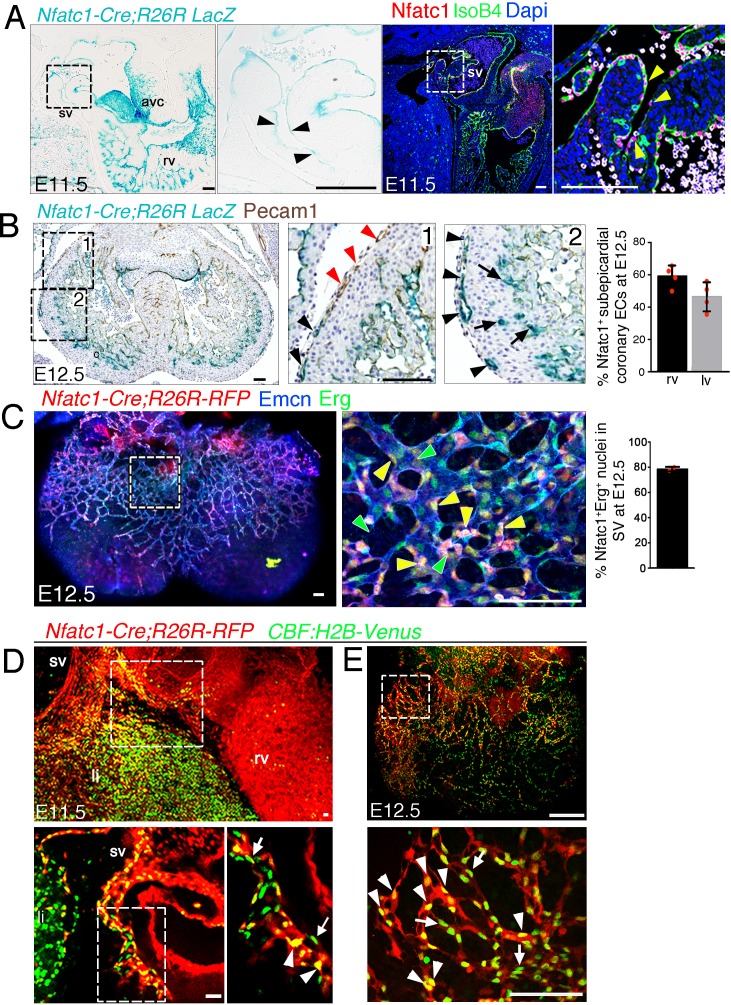
Most ventricular free-wall coronary vessels derive from Nfatc1+ progenitors.Nfatc1+ progenitors give rise to most coronary vessels. (A) Left: Sagittal section of a E11.5 Nfatc1-Cre;R26R-LacZ heart, showing LacZ expression in the sinus venosus (sv; arrowheads in inset), right ventricle (rv), and atrioventricular canal (avc). Right: Sagittal section of a E11.5 control heart immunostained for Nfatc1 (red) and IsoB4 (green); yellow arrowheads indicate nuclear Nfatc1 staining in SV endothelial cells. Dapi counterstain (blue). Scale bars 100 μm. (B) E12.5 Nfatc1-Cre;R26R-LacZ heart co-stained for LacZ and Pecam-1. (1) LacZ staining is weak in vessels proximal to the AVC (red arrowheads) and strong in distal vessels (1, 2, black arrowheads). (2) LacZ staining in vessels close to chamber endocardium is consistent with an endocardial origin of coronary arteries (arrows). The chart shows Nfatc1-positive vessels (Nfatc1-Cre-driven LacZ expression) as a percentage of all sub-epicardial vessels (Pecam-1-stained). Data are mean ± s.d. (n = 3 sections from four embryos). (C) Whole-mount E12.5 Nfatc1-Cre;Rosa26-RFP heart (dorsal view), showing RFP fluorescence (red) and immunhistochemistry for Emcn (blue) and Erg (green). Sub-epicardial vessel endothelium contains Nfatc1-Cre;Rosa26-RFP-positive nuclei (yellow arrowheads) and Nfatc1-Cre;Rosa26-RFP-negative nuclei (green arrowheads). Dapi counterstain (blue). The chart shows Nfatc1-Erg dual-positive nuclei as a percentage of all nuclei in subepicardial vessels. Data are mean ± s.d. (n = 2 hearts). Scale bars, 100 μm. (D) Whole-mount E11.5 Nfatc1-Cre;Rosa26-RFP:CBF:H2B-Venus heart (dorsal view), showing RFP reporter fluorescence (red) and immunohistochemistry for GFP (green). The Z-stack of SV endothelium shows Nfatc1-Cre;Rosa26-RFP-CBF:H2B-Venus double-positive nuclei (arrowheads) and CBF:H2B-Venus single-positive nuclei (arrows). sv, sinus venosus; rv, right ventricle; li, liver. (E) Whole-mount E12.5 Nfatc1-Cre;Rosa26-RFP-CBF:H2B-Venus heart (dorsal view), showing RFP reporter expression (red) and immunohistochemistry for GFP (green). The sub-epicardial vessel endothelium contains Nfatc1-Cre;Rosa26-RFP, CBF:H2B-Venus dual-positive nuclei (white arrowheads) and CBF:H2B-Venus single positive nuclei (arrows). Scale bars, 100 μm. Images for fluorescence immunostainings were acquired on a Nikon A1-R microscope. Software: NIS Elements AR 4.30.02. Build 1053 LO, 64 bits. Objectives: Plan Apo VC 20x/0,75 DIC N2 dry; Plan Fluor 40x/1,3 Oil DIC H N2 Oil.